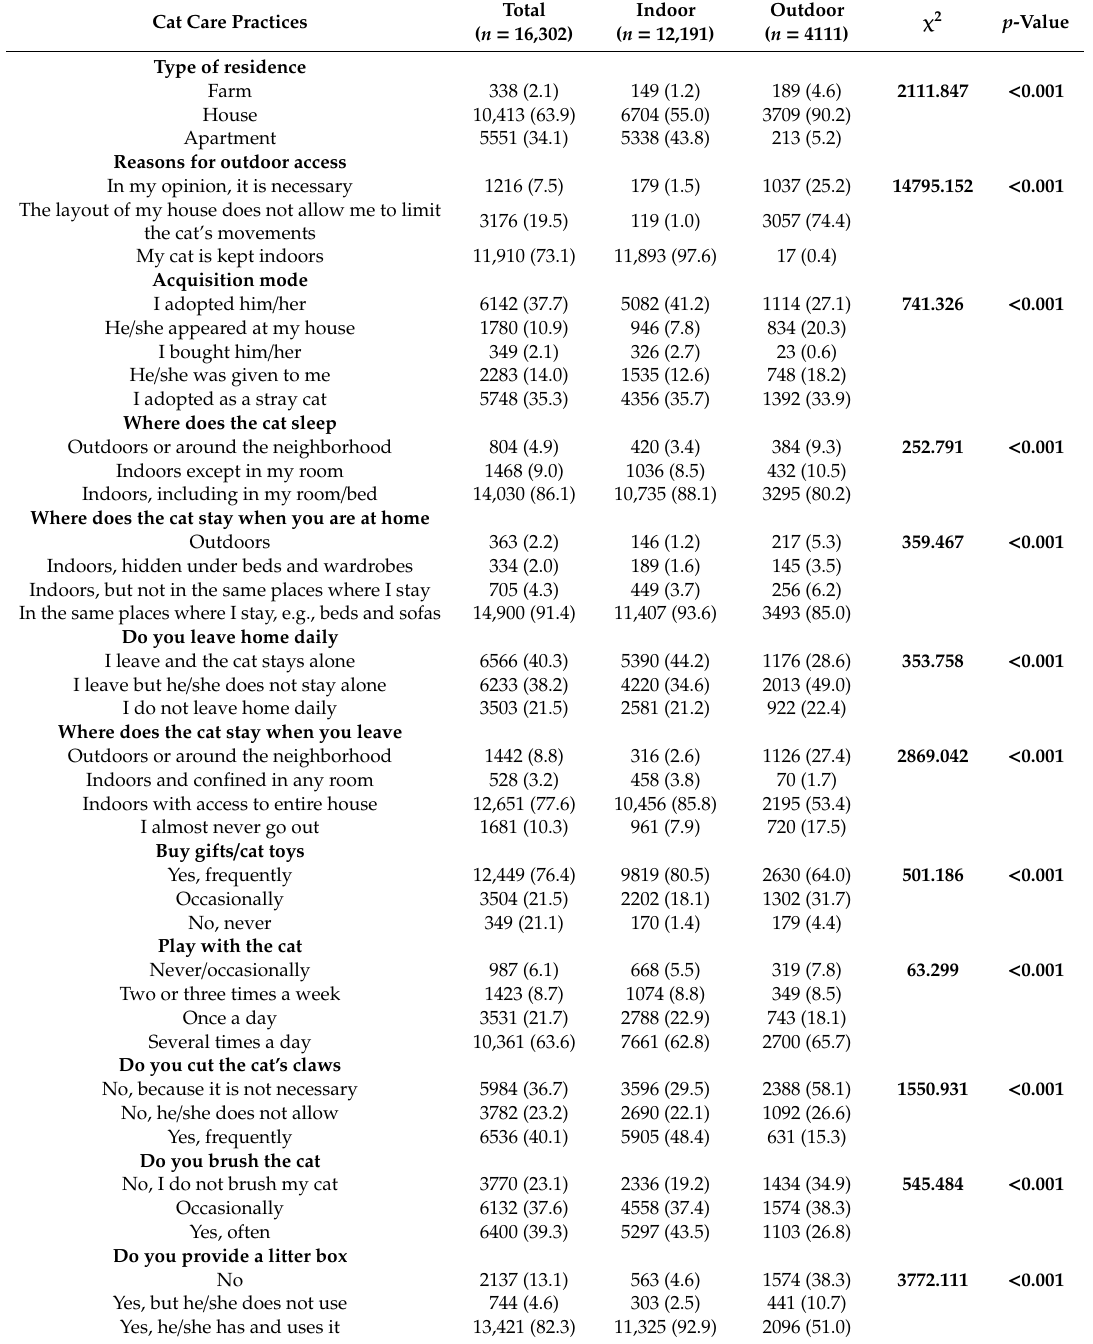
Table 1. Absolute and relative frequencies (%, within parentheses) of cat care practices and human-cat interactions for cat population sampled (total) and for cats kept indoors and outdoors. Chi-square tests (or Fisher’s Exact tests in 2 × 2 table) are shown to test the association between each practice and the type of management (indoor vs. outdoor). Significant values are shown in